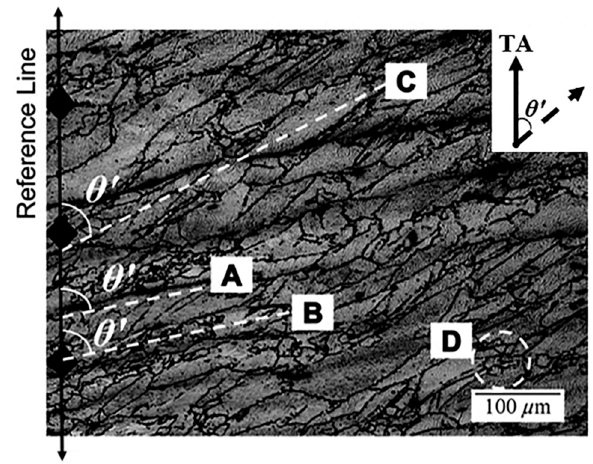
Figure 2. Light optical micrograph from the tangential plane cross-section of the prior austenite microstructure produced via industrial bar rolling simulations on a 1045 steel microalloyed with V using hot torsion testing. MnS inclusions (A) and some austenite grains (B) accumulate all imposed shear strain without recrystallizing. Other austenite grains (C) deform in shear after recrystallizing or (D) recrystallize following the final deformation pass. The torsional axis (TA) is vertical to the page, parallel to the reference line indicated. Adapted with permission from [19].